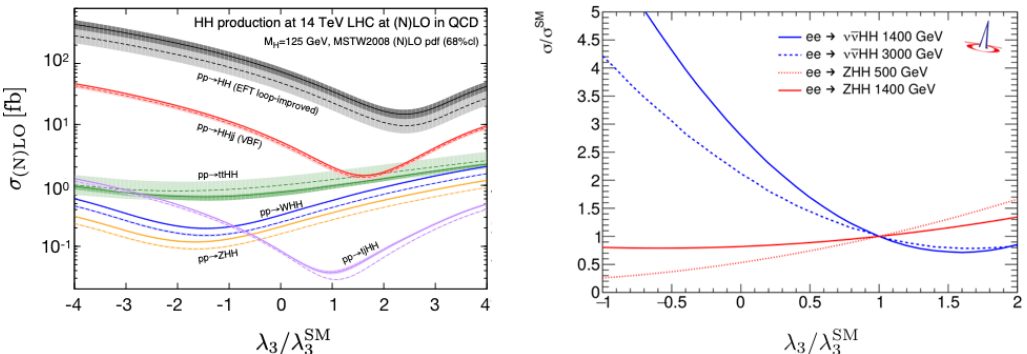
Figure 10 . Double Higgs production at hadron (left) [65] and lepton (right) [66] colliders as a function of the modi(cid:12)ed Higgs cubic self-coupling. See table 18 for the SM rates. At lepton colliders, the production cross sections do depend on the polarisation but this dependence drops out in the ratios to the SM rates (beam spectrum and QED ISR e(cid:11)ects have been